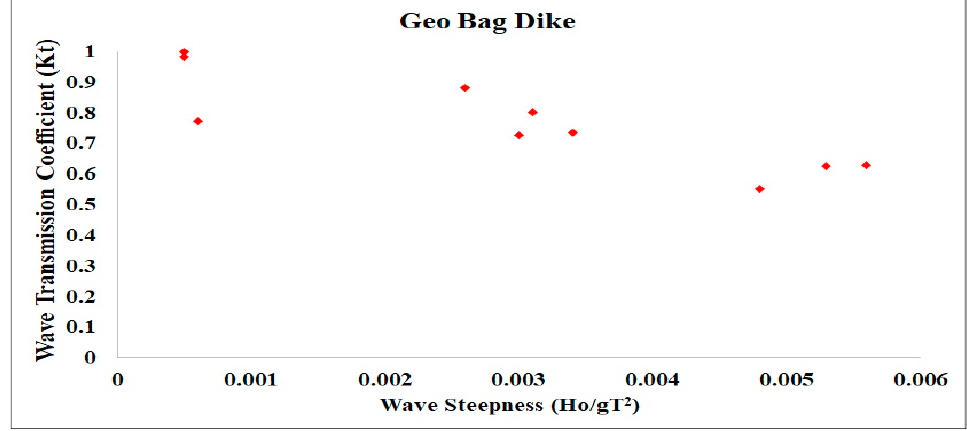
Figure 2. Plot between the wave transmission coefficient and wave steepness for geo-bag dike structures (adapted from Yuanita et al.) [35].